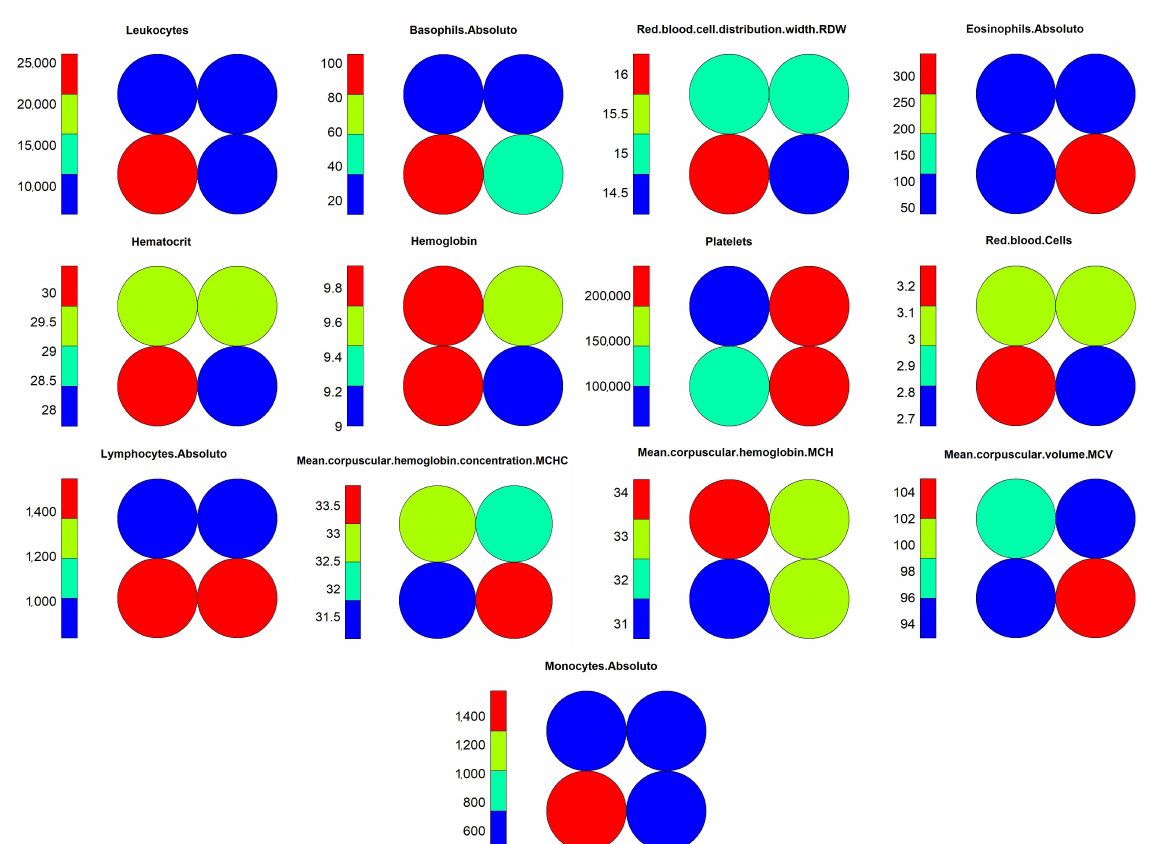
Figure 22. Heatmap of the variables per neuron in level 3— TESSOM .